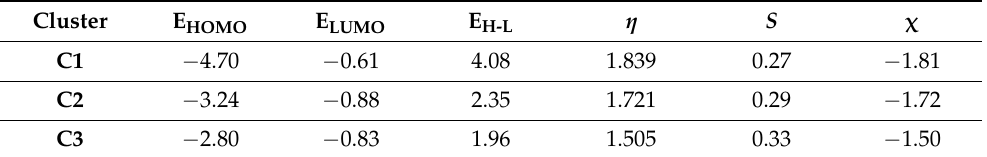
Table 2. Energies of HOMO (E HOMO in eV), LUMO energies (in eV), HOMO-LUMO gaps (E H-L in eV), chemical hardness ( η in eV), chemical, softness ( S in eV), chemical potential ( χ in eV), oscillator strength ( f o in au), excitation energies (eV), and maximum absorption (in nm) of C1 to C3 clusters. Cluster E HOMO E LUMO E H-L η S χ C1 − 4.70 − 0.61 4.08 1.839 0.27 − 1.81 C2 − 3.24 − 0.88 2.35 1.721 0.29 − 1.72 C3 − 2.80 − 0.83 1.96 1.505 0.33 −